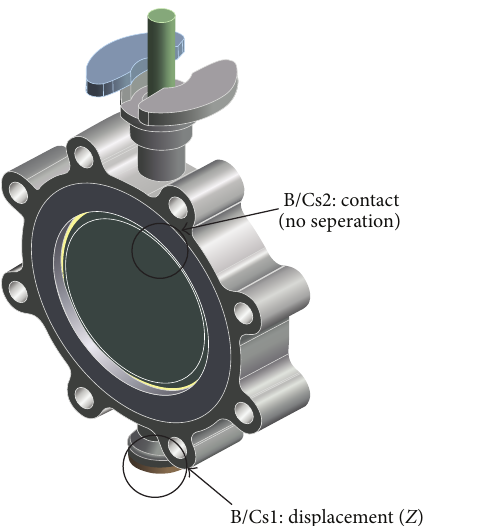
Figure 9: Boundary conditions for modal analysis based on dynamic